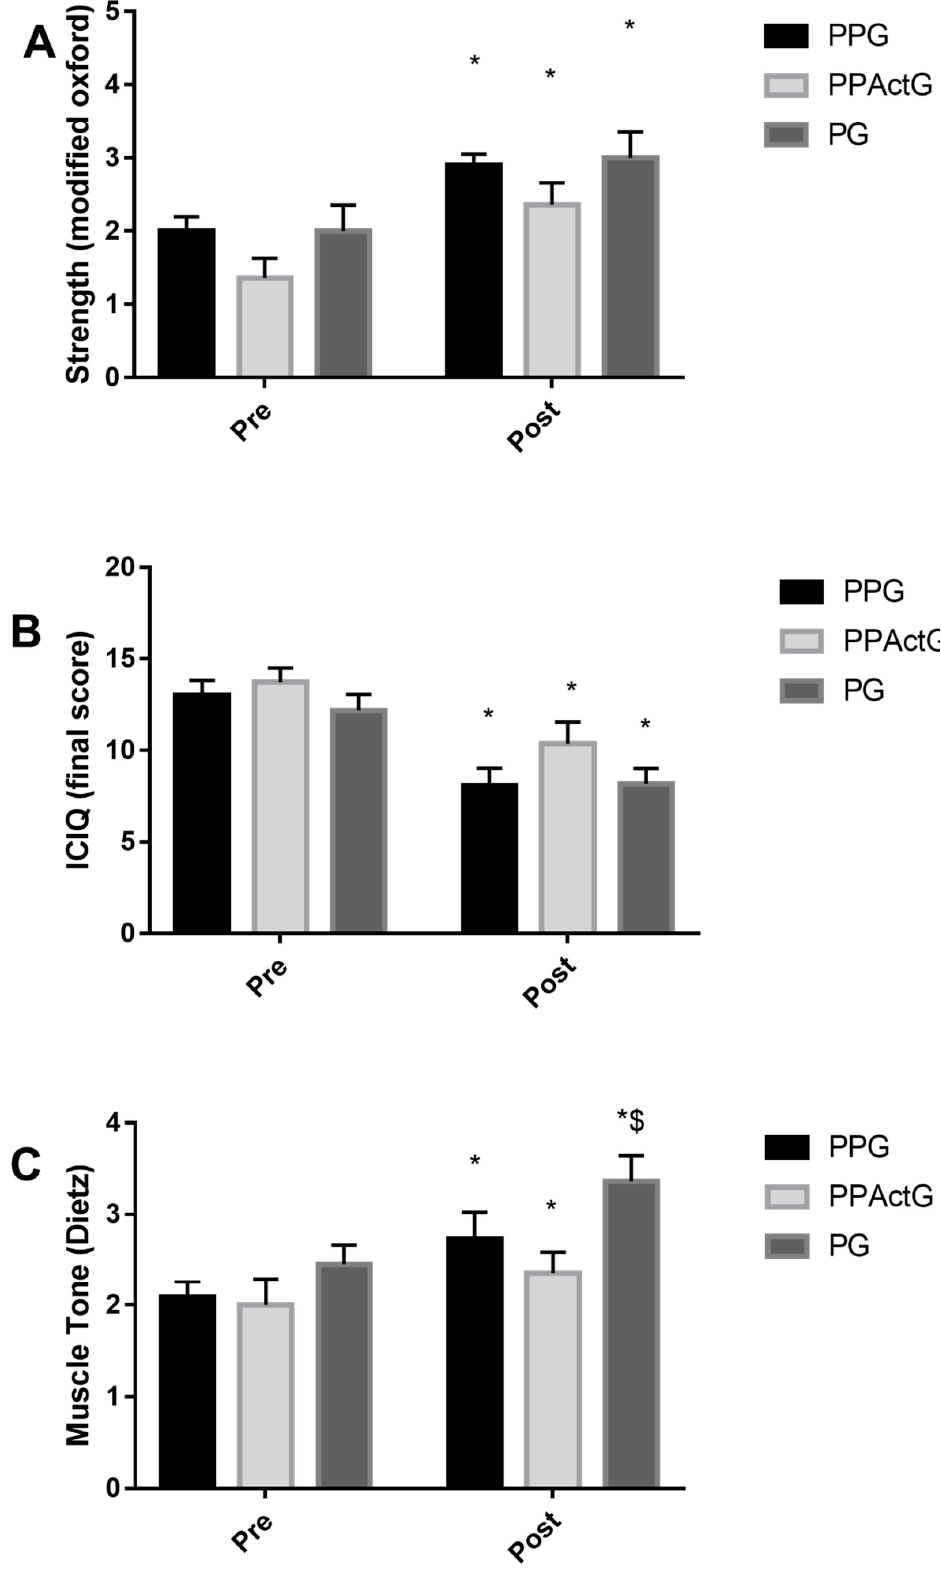
Figure 2. ( A , B ) * Statistically significant difference in comparison with the pre ( p < 0.01); ( C ) * Statisti- cally significant difference in comparison with the pre ( p < 0.05), $ Statistically significant difference in comparison with the Post PPActG ( p =